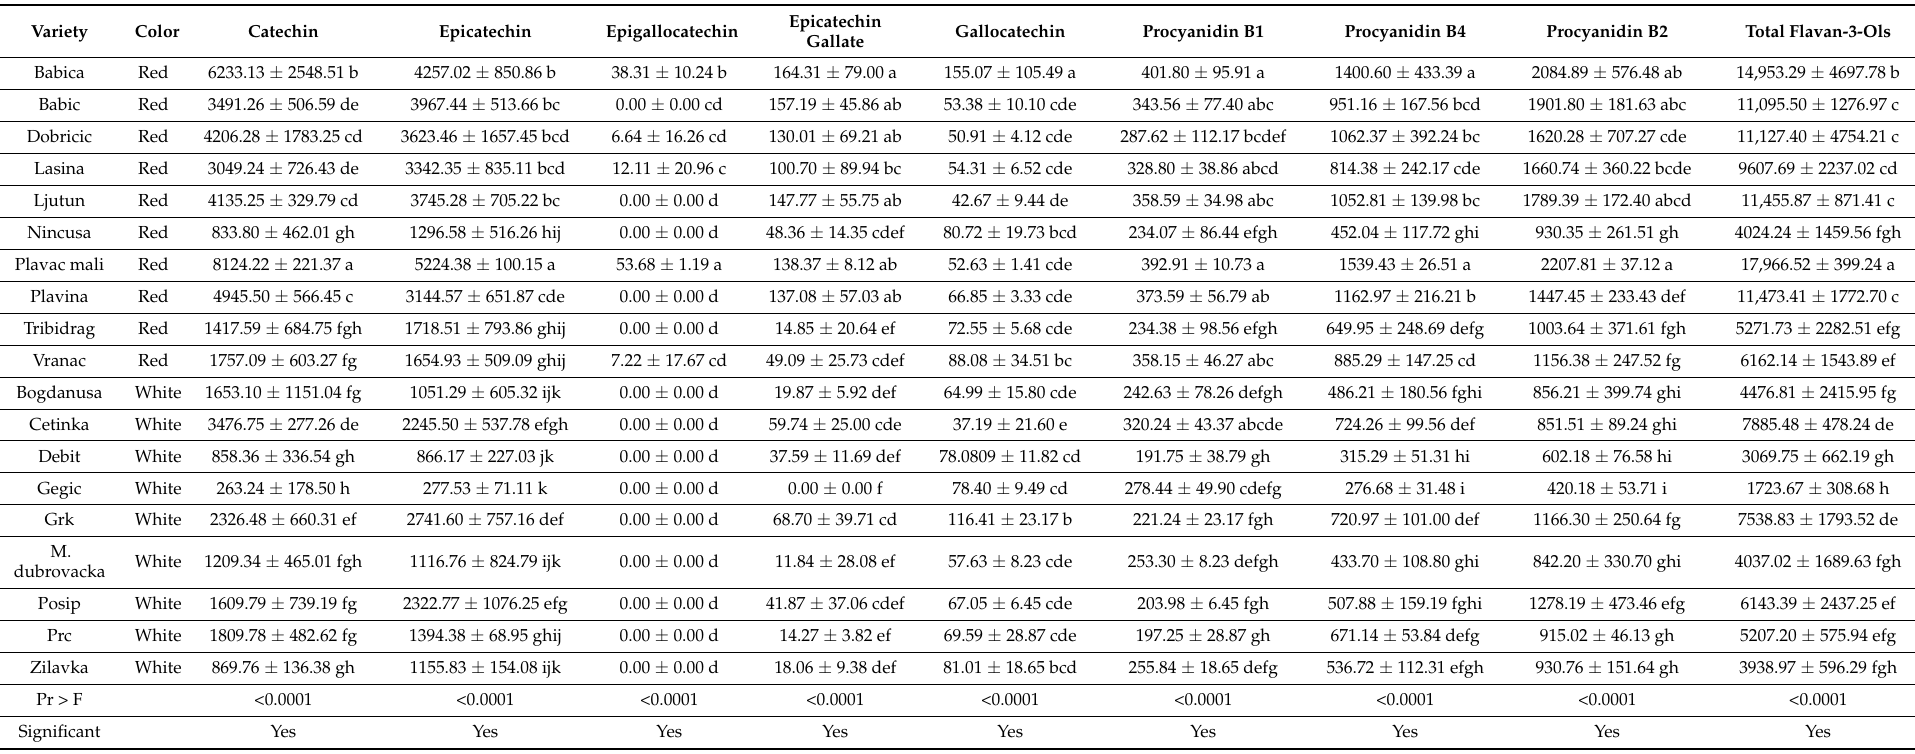
Table 3. Content of flavan-3-ols (mg/kg) in analyzed red and white cultivars. Means with different letters in the same column differ significantly ( p ≤